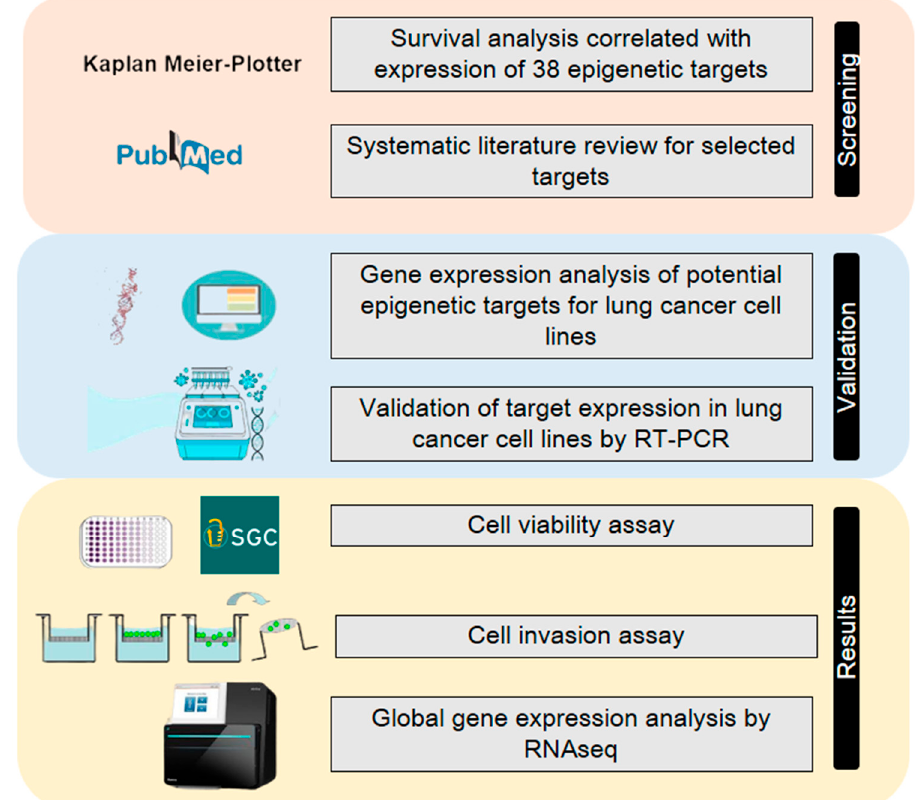
Figure 4. The streamlined approach using in silico and in vitro experiments. The initial screening was performed using publicly available data of lung cancer samples from TCGA using the KMplotter. Then, a systematic review of the significant candidates was performed to exclude the already described targets in the literature for lung cancer. The potential candidates were evaluated by gene expression in cancer cell lines, first, in silico and, then, experimentally in cancer cells. Lastly, experiments for cytotoxicity, an invasion assay and transcriptomic analyses were performed.